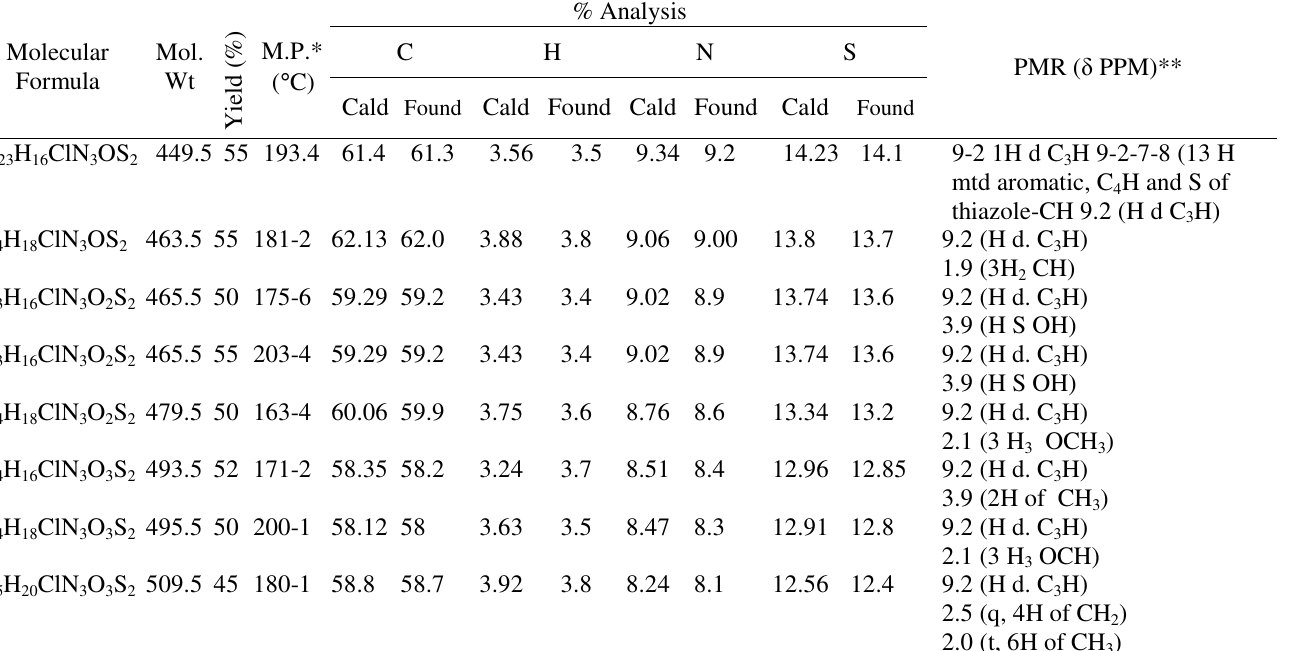
Table 1. Analytical and spectral Data of Commands 4a-h %